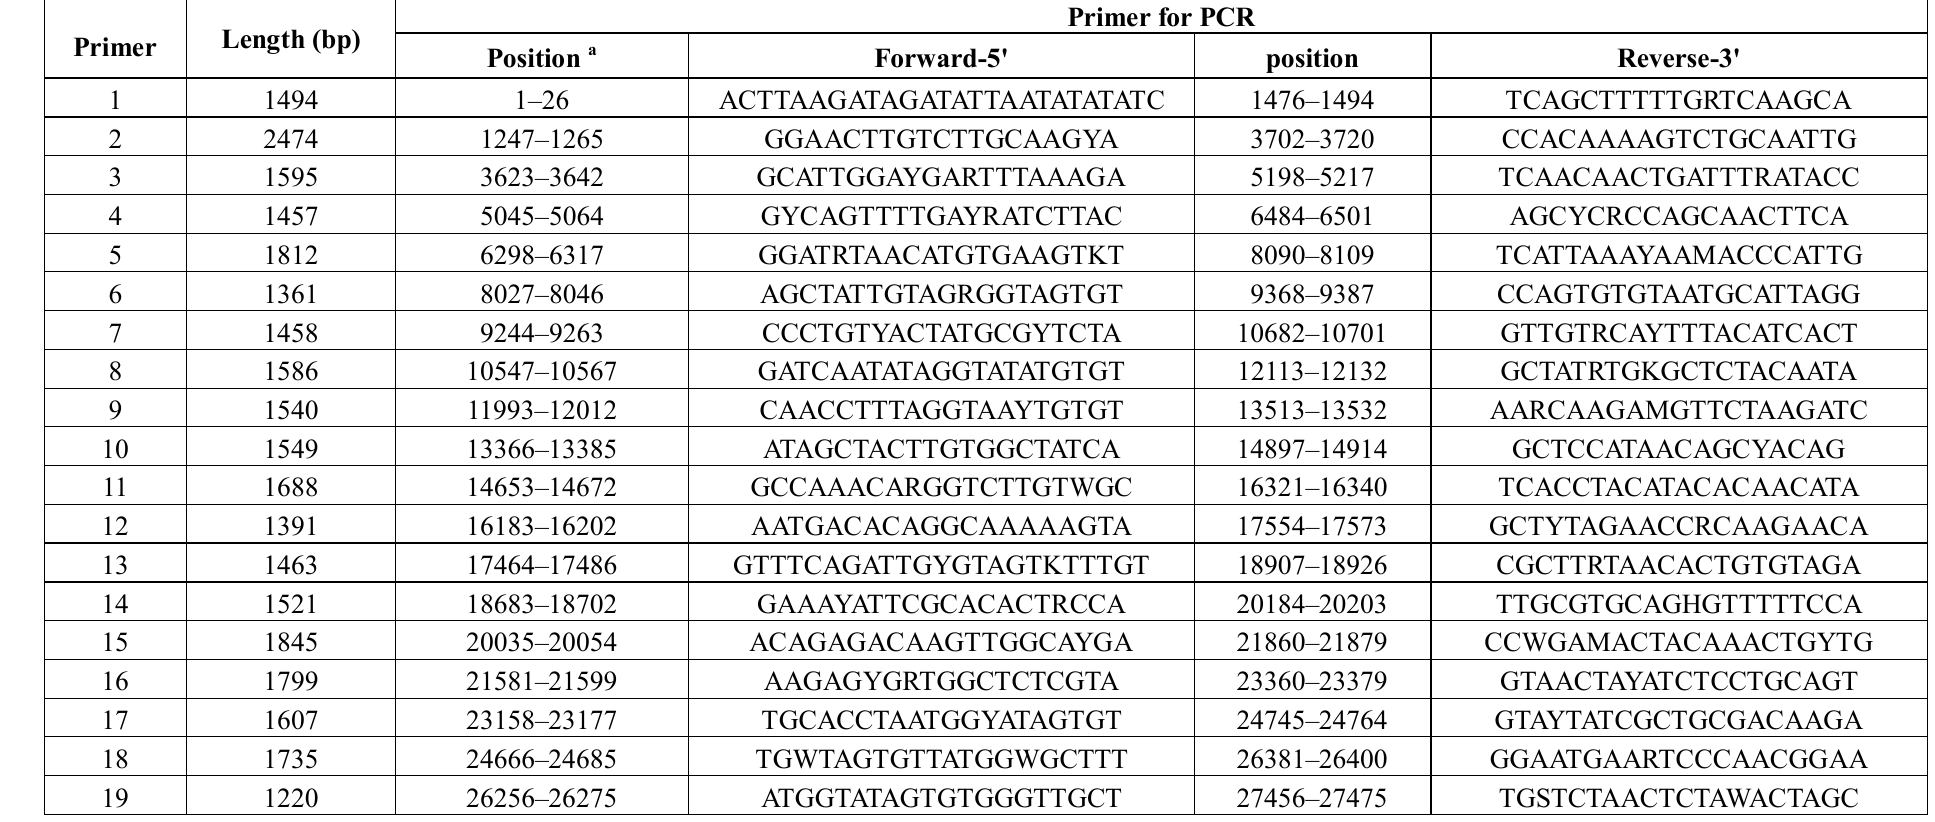
Table 4. The oligonucleotide primers used for amplification and sequencing of the complete SNU8067 and KM91